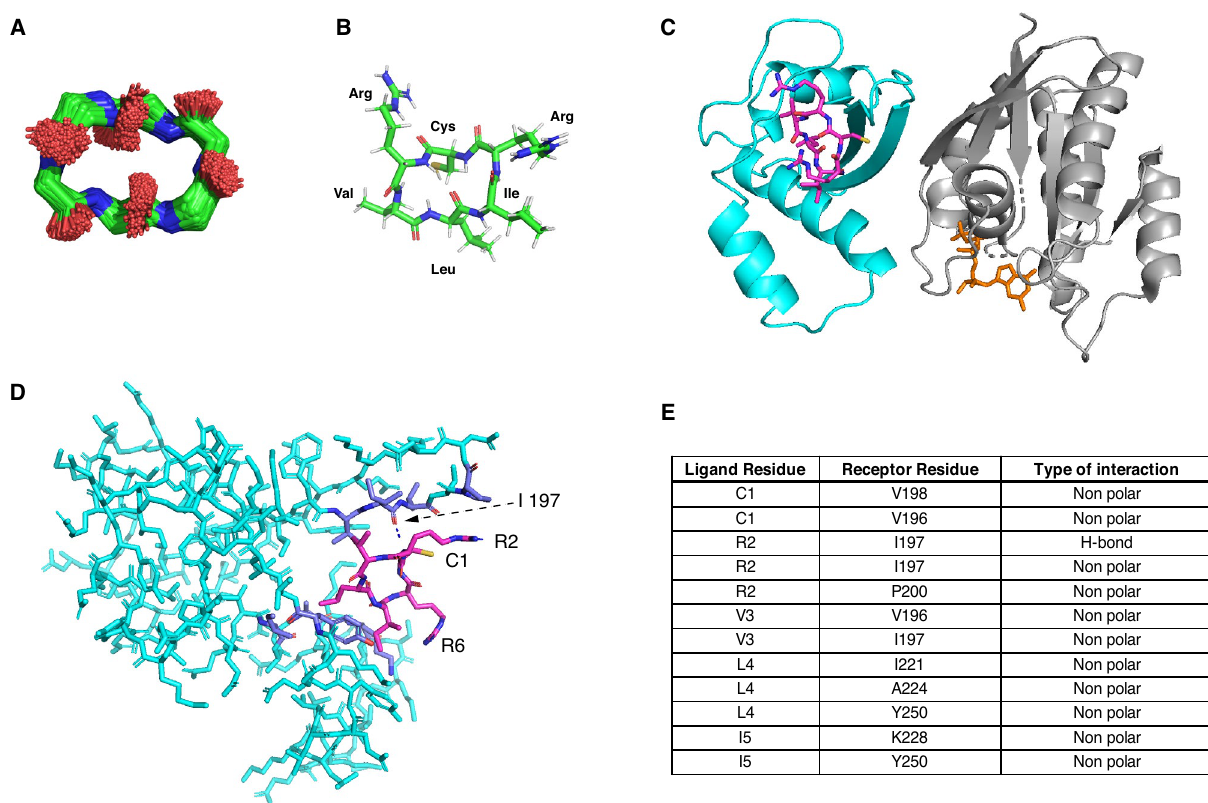
Figure 4. Modelling of the cyclo-CRVLIR and molecular docking on the p110α-RBD. ( A ) Illustration of the backbone conformations of cyclo-CRVLIR during a 10 ns Molecular Dynamic Simulation (MDS). ( B ) Proposed model of cyclo-CRVLIR structure based on the MDS studies. ( C ) A cartoon model based on previous published structure of GTP bound (orange) HRAS (grey) to p110γ (PDB: 1HE8). A previously published structure of p110α (cyan) (PDB: 4TV3) was aligned on top of the p110γ to represent a binding model of p110α with RAS protein 8,37 . The model shows the binding of cyclo-CRVLIR (magenta) to p110α at a site that is not involved in the binding with RAS—indicating allosteric inhibition of the p110α/RAS interaction. It is worth emphasising that the presence of RAS in this model is a representation to help indicate that the peptide binds to the RBD allosterically and not through he RBD/RAS interface, ( D ) Representation of cyclo-CRVLIR bound to p110α- RBD and possible formation of hydrogen bonds between R2 of cyclo-CRVLIR and I197 in p110α (black dashed lines). This also shows that R6 is not involved in the binding of the peptide to p110α, although it could be playing a major role in cellular penetration ( E ) A table showing each amino acid of cyclo-CRVLIR and its possible binding residues in the p110α